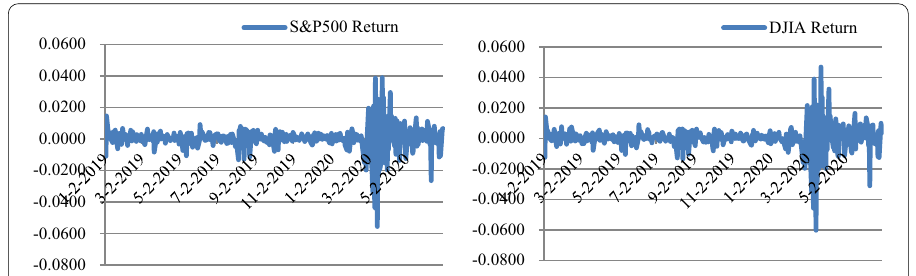
Fig 2. Time Series Plots: 01/01/2019–06/30/2020 . Notes : Figure 2 plots the time series of both S&P 500 and DJIA for the period January 1st, 2019 to June 30th, 2020